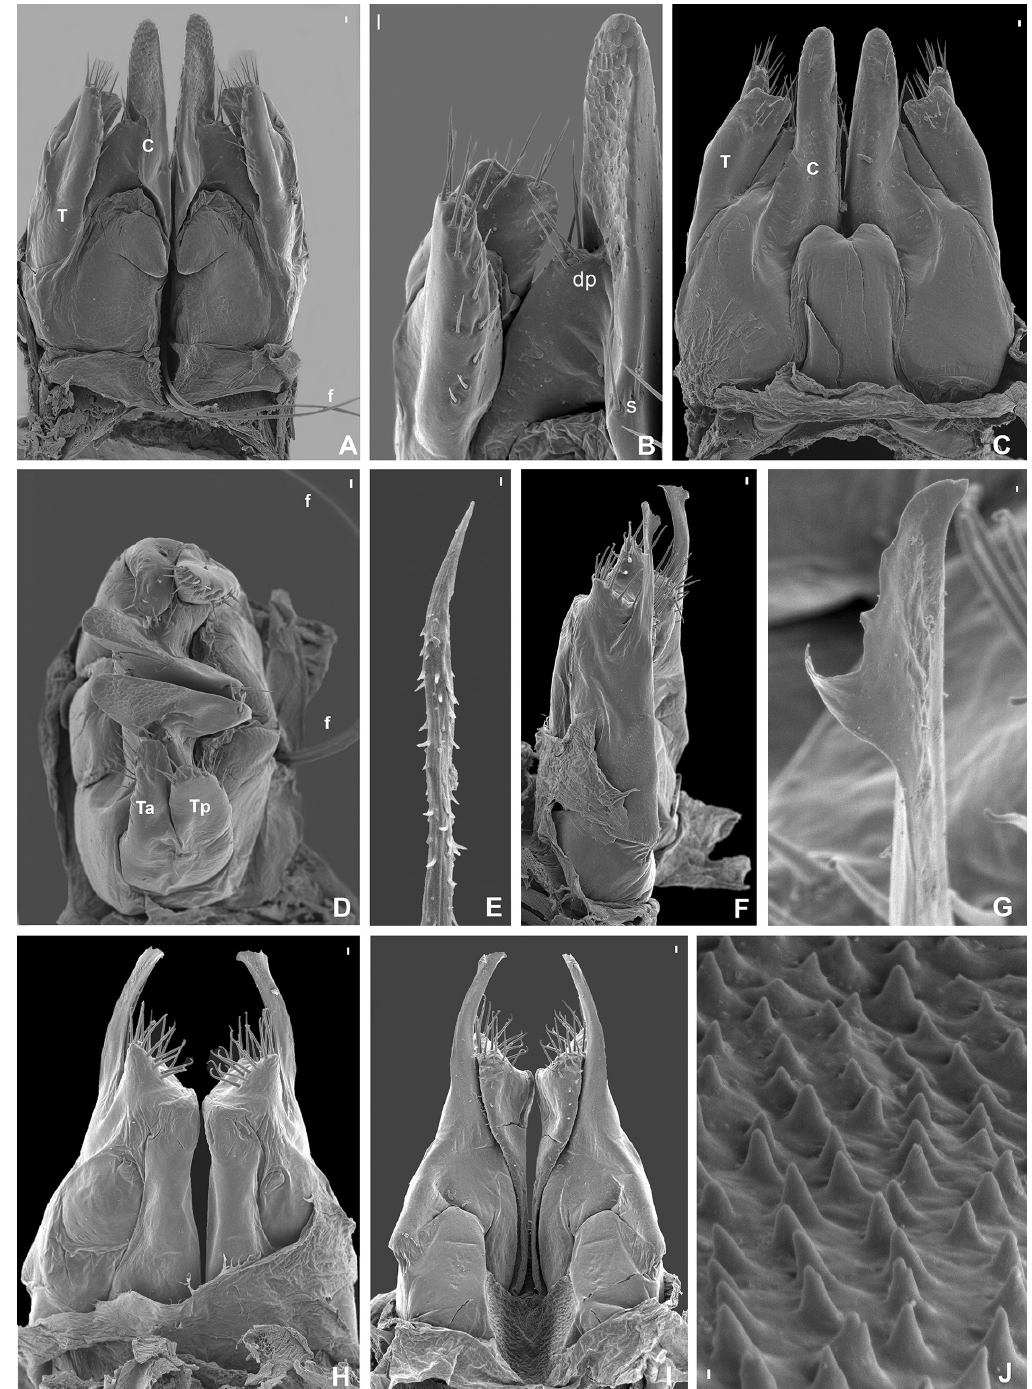
Fig. 9. Chiraziulus troglopersicus sp. nov., ♂, paratype, gonopods. Scanning electron micrographs. A . Anterior gonopods in posterior view. B . Detail of the process on the tip of an anterior gonopod in posterior view. C . Anterior gonopods in anterior view. D . As C, in apical view. E . Tip of the flagellum. F . Posterior gonopods in lateral view. G . Tip of the long spine-like process of the posterior gonopod. H . Posterior gonopods in posterior view. I. As H, in anterior view. J . Detail of the mesal sternal part of the gonopods. Abbreviations: C = coxal process; T = telepodite; f = flagellum; s = setae; dp = distal process. Scale bars: A–D, F, H–I = 10 μm; E, G, J = 1